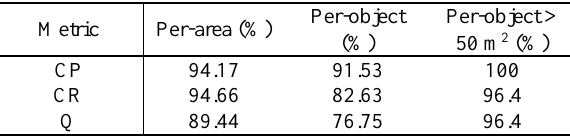
Table 2 . The results of the building